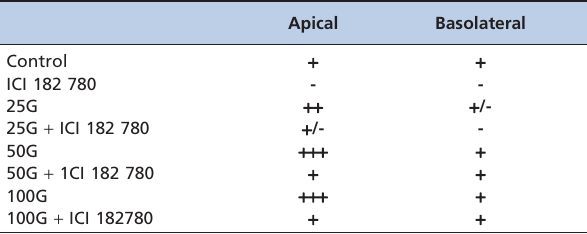
Table 2 - Semi-quantitative analysis of the intensity of CFTR immunostaining following different doses of genistein treatment (25, 50, and 100 mg/kg/day) with and without ICI 182780. The staining intensity was graded as follows: 2 , negative; 2 / + , faint; + , moderate; ++ strong and +++ , very intense. The intensity was confirmed by 3 independent